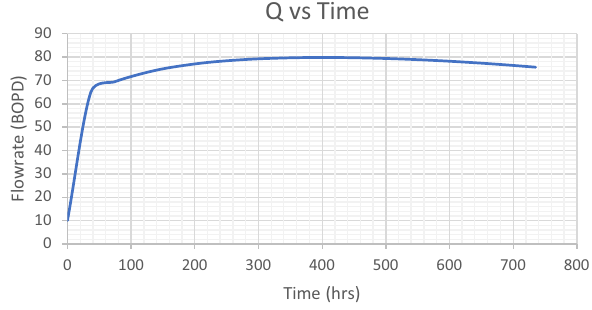
Fig. 7 Flowrate vs time from numerical